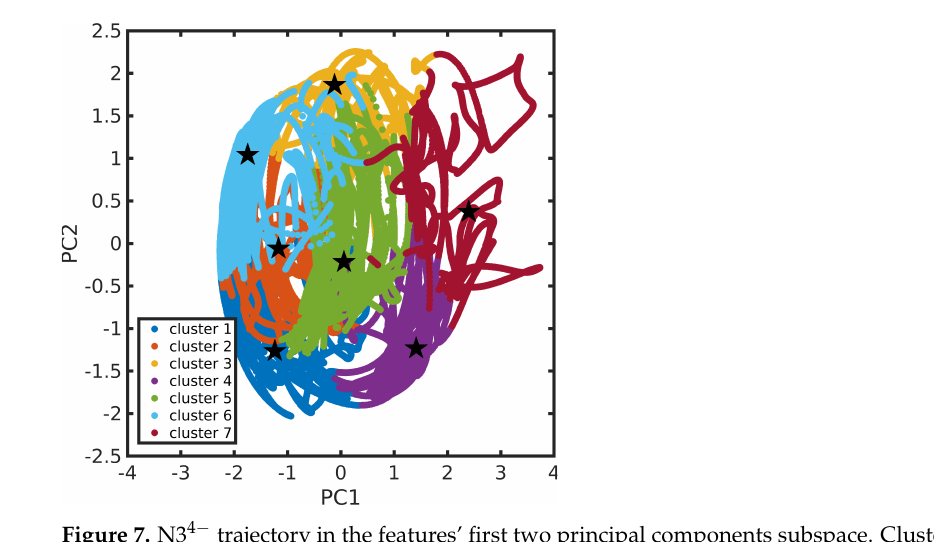
Figure 7. N3 4 − trajectory in the features’ first two principal components subspace. Cluster partition is represented through different colors. Cluster medoids are also highlighted (as star symbols).